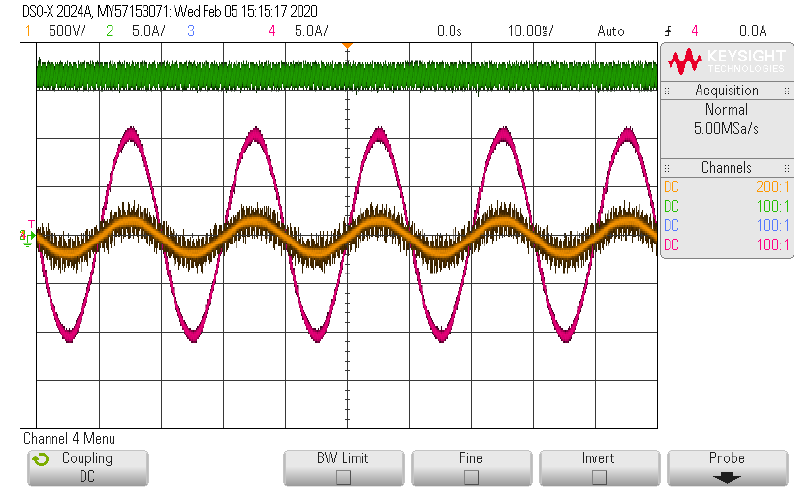
Figure 11. Steady-state